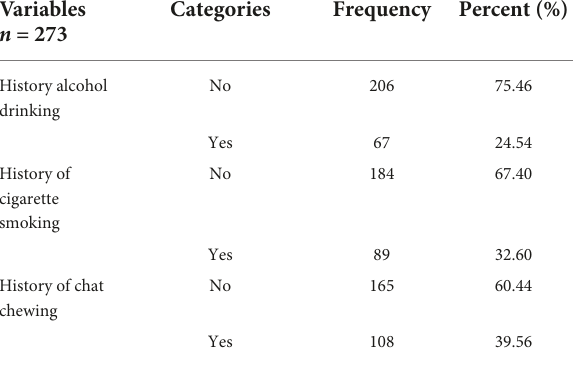
from 2013 to 2021 ( N =